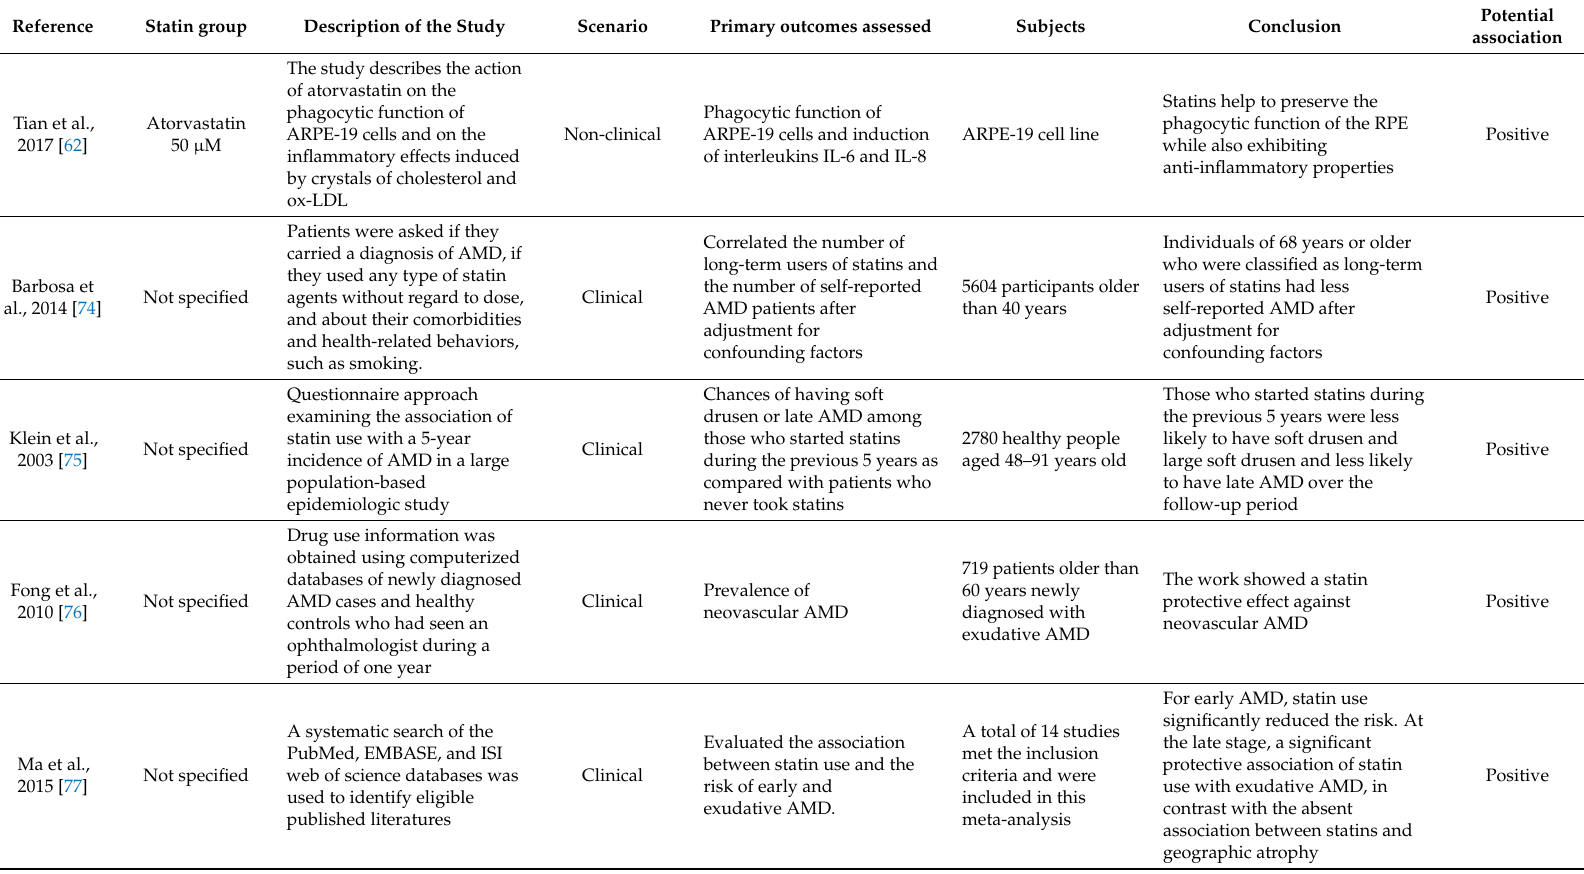
Table 1. Summary of findings supporting the positive or negative association between statins and